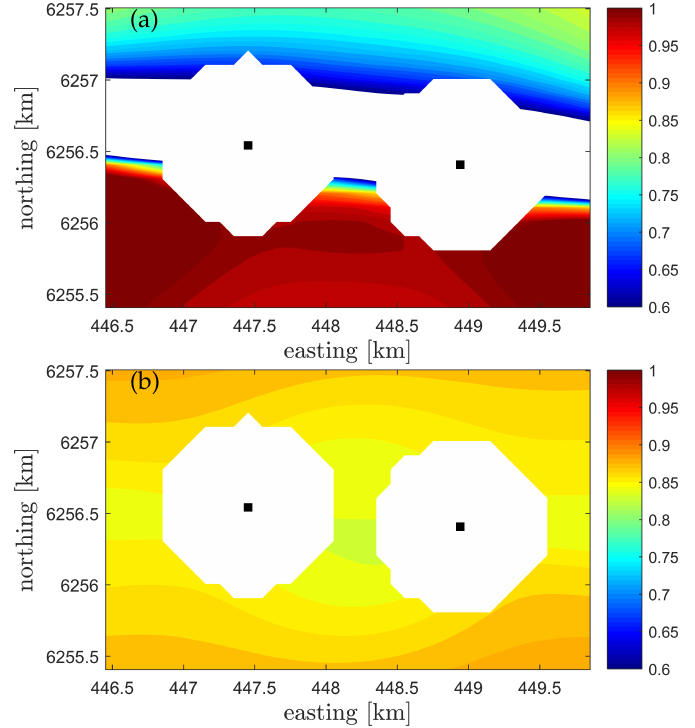
Figure 13. Same as Figure 12 but for a 180 ◦